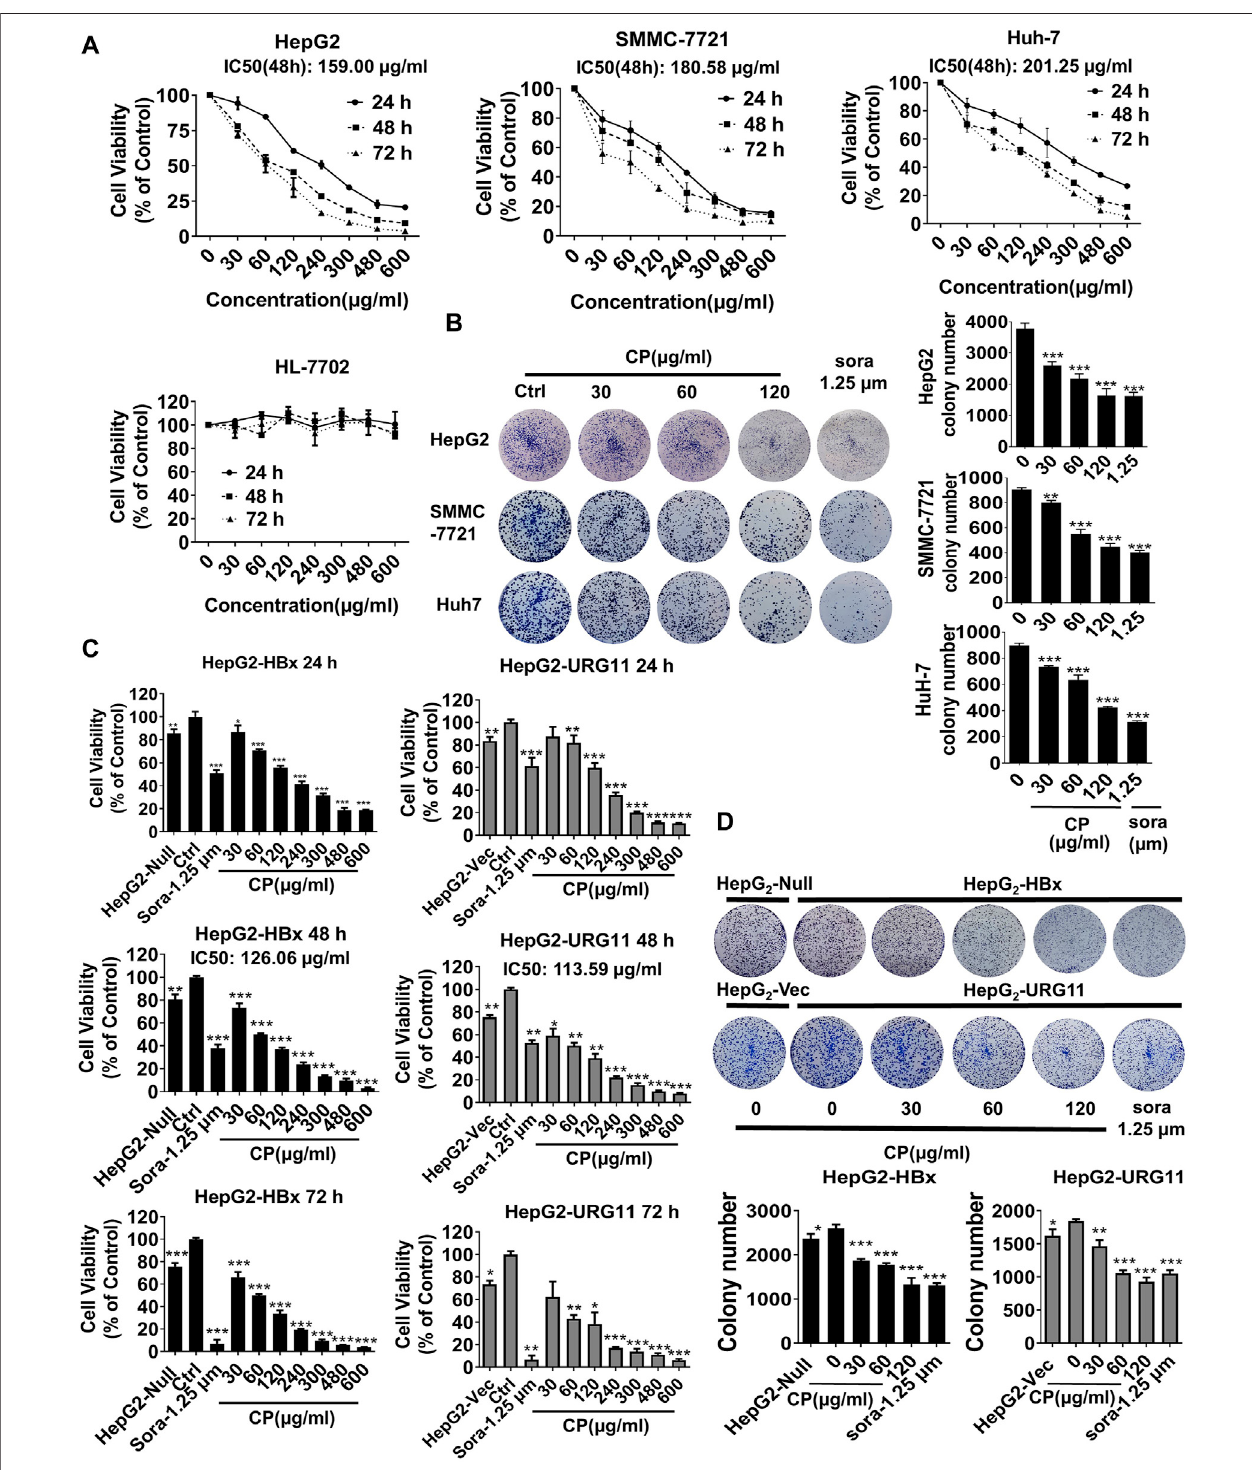
FIGURE1| CPsuppressed the proliferation ofHBV-associated phenotypes ofHCC cells. (A) CPexhibited obvious inhibition on HepG2, SMMC-7721 and HuH-7 inatime-concentration dependentmannerandhad noobviouseffect onnormalhepatic cellHL-7702. (B) CPsigni fi cantlyreducedcolonysizeandnumberofHCCcells including HepG2, SMMC-7721 and HuH-7. (C) CP administration suppressed the proliferation of HBV-associated HCC cell including HepG2-HBx and HepG2-URG11 cellsinadose-dependentmanner. (D) CPsigni fi cantlyinhibitedthecloneformationcapabilityofbothHepG2-HBxandHepG2-URG11cells.Allvaluesrepresented the means ± SD ( n (cid:1) 3, * p < 0.05, ** p < 0.01, *** p < 0.001). sora: sorafenib.